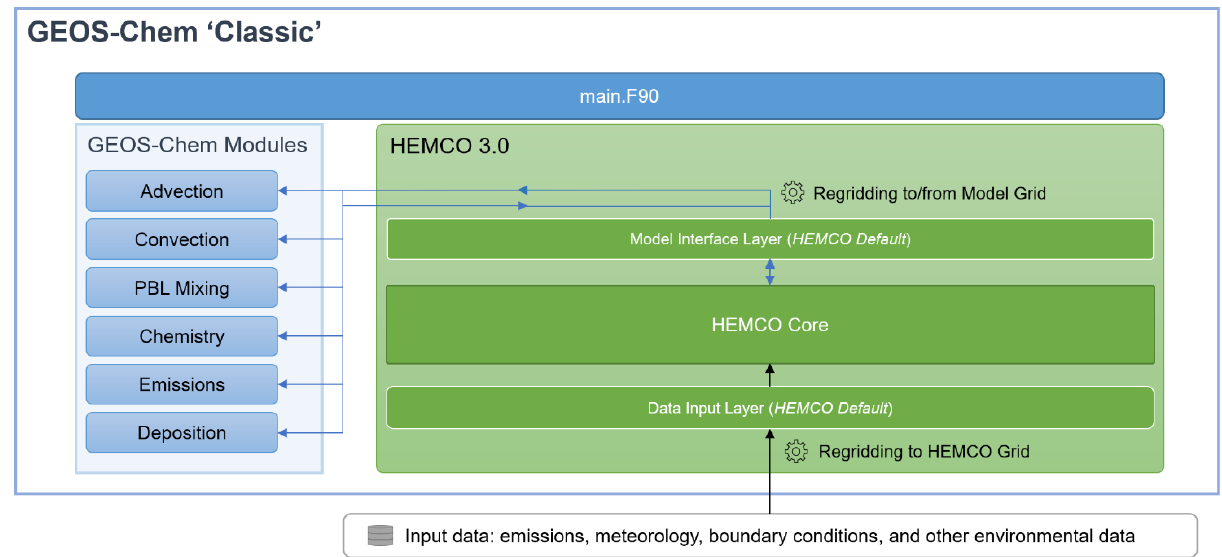
Figure 4. HEMCO 3.0 implementation in the GEOS-Chem Classic model. HEMCO in GEOS-Chem Classic is a general input data broker. The main model driver routine main.F90 successively calls each GEOS-Chem module and HEMCO in a time step loop. HEMCO 3.0 reads all input data through the default Data Input Layer, processes the data through the HEMCO Core, and exports the data to each GEOS-Chem module through the HEMCO default Model Interface Layer. The Model Interface Layer also receives data from GEOS-Chem modules that are used by HEMCO to compute state-dependent emissions through extensions.